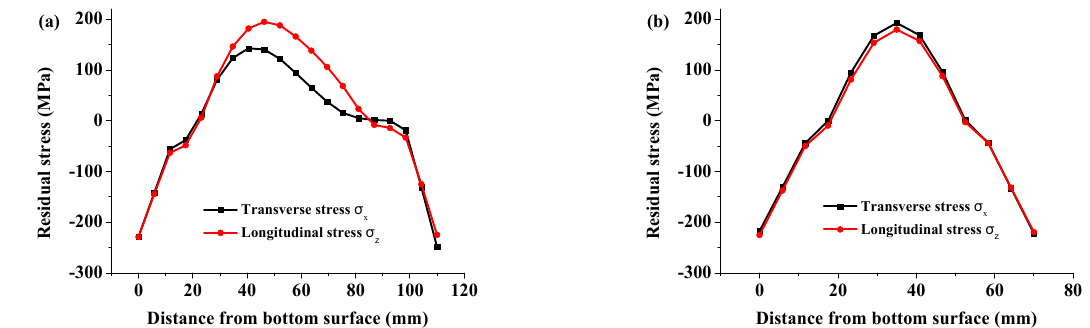
Figure 5. Residual stress distribution of quenched T-type rib: ( a ) Longitudinal residual stress; ( b ) transverse residual stress.